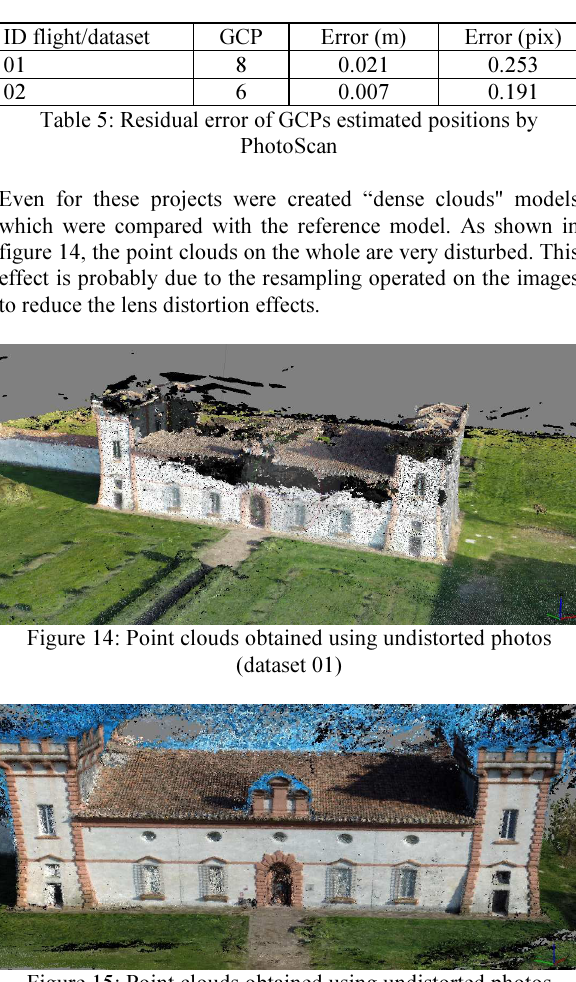
Figure 15: Point clouds obtained using undistorted photos (dataset